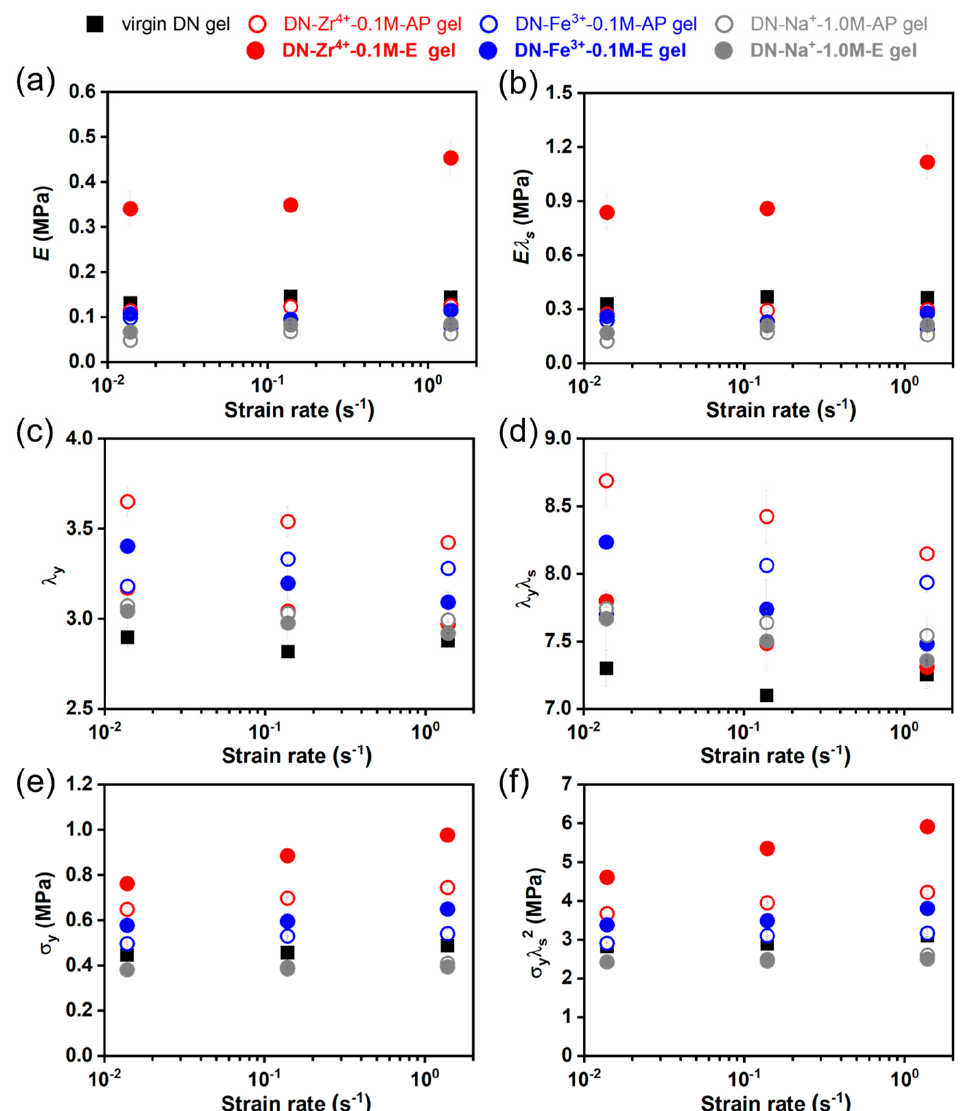
Figure 8. ( a , b ) Dependence of the Young’s modulus E ( a ) and the rescaled Young’s modulus E λ s ( b ) on strain rate for various DN hydrogels. ( c , d ) Dependence of the yielding stretch ratio λ y ( c ) and the rescaled yielding stretch ratio λ y λ s ( d ) on strain rate for various DN hydrogels. ( e , f ) Dependence of the yielding stress σ y ( c ) and the rescaled yielding stress σ y λ s2 ( d ) on strain rate for various DN hydrogels.